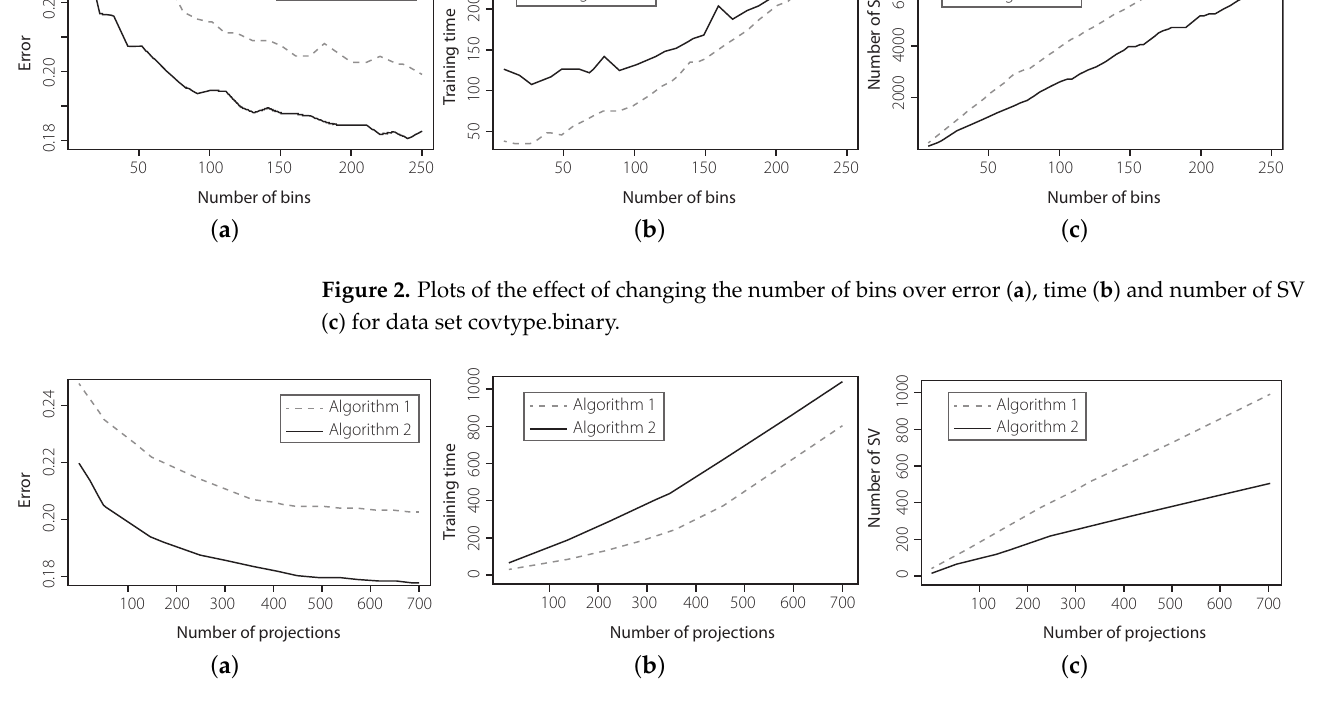
Figure 3. Plots of the effect of changing the number of projections over error ( a ), time ( b ), and number of SV ( c ) for data set